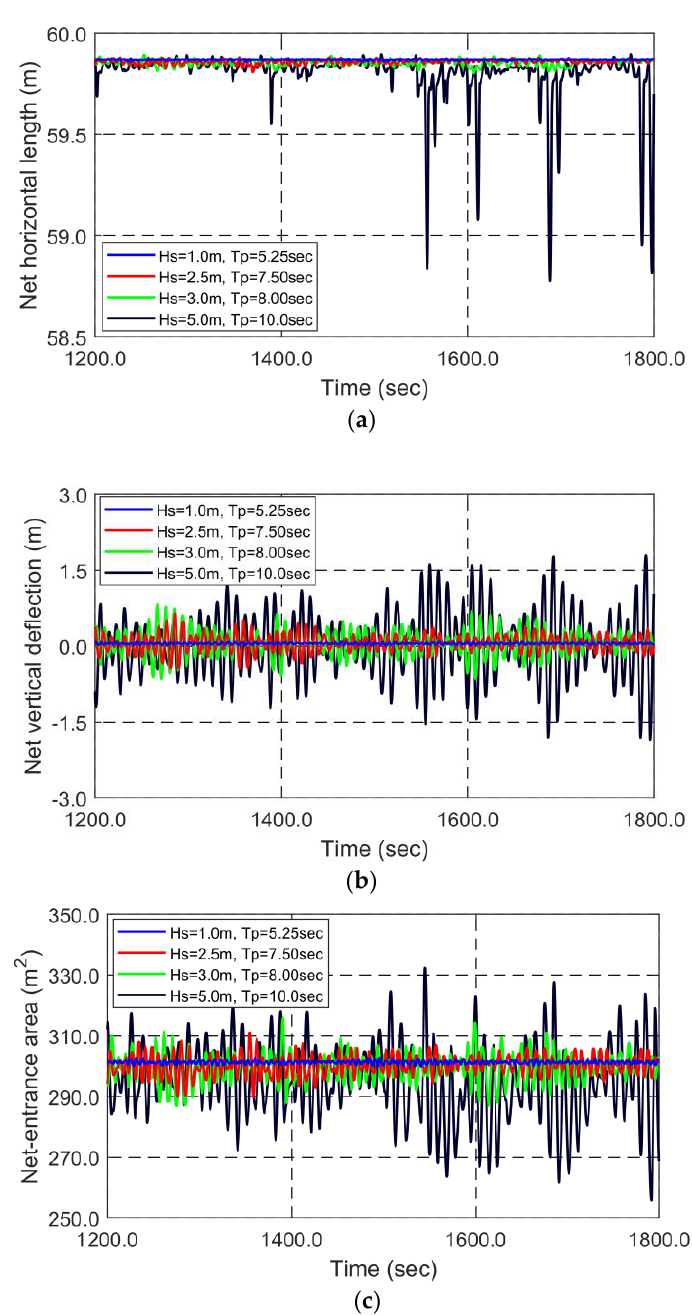
Figure 7. Time histories of net horizontal length ( a ), net vertical deflection ( b ), and net-entrance area ( c ) in varying wave conditions under the identical current velocity ( V c = 1.0 m/sec).